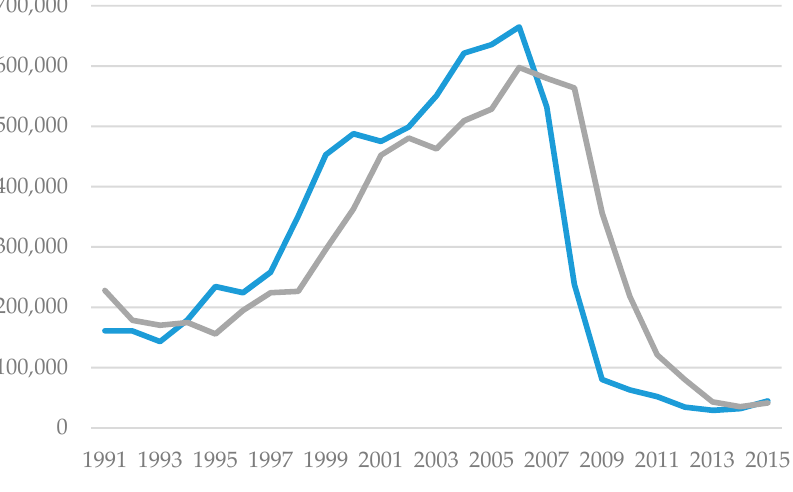
Figure 1. Construction activity in Spain (1991–2015). Housing starts and housing completions. Ministerio de Transporte, Movilidad y Agenda Urbana. Own elaboration.